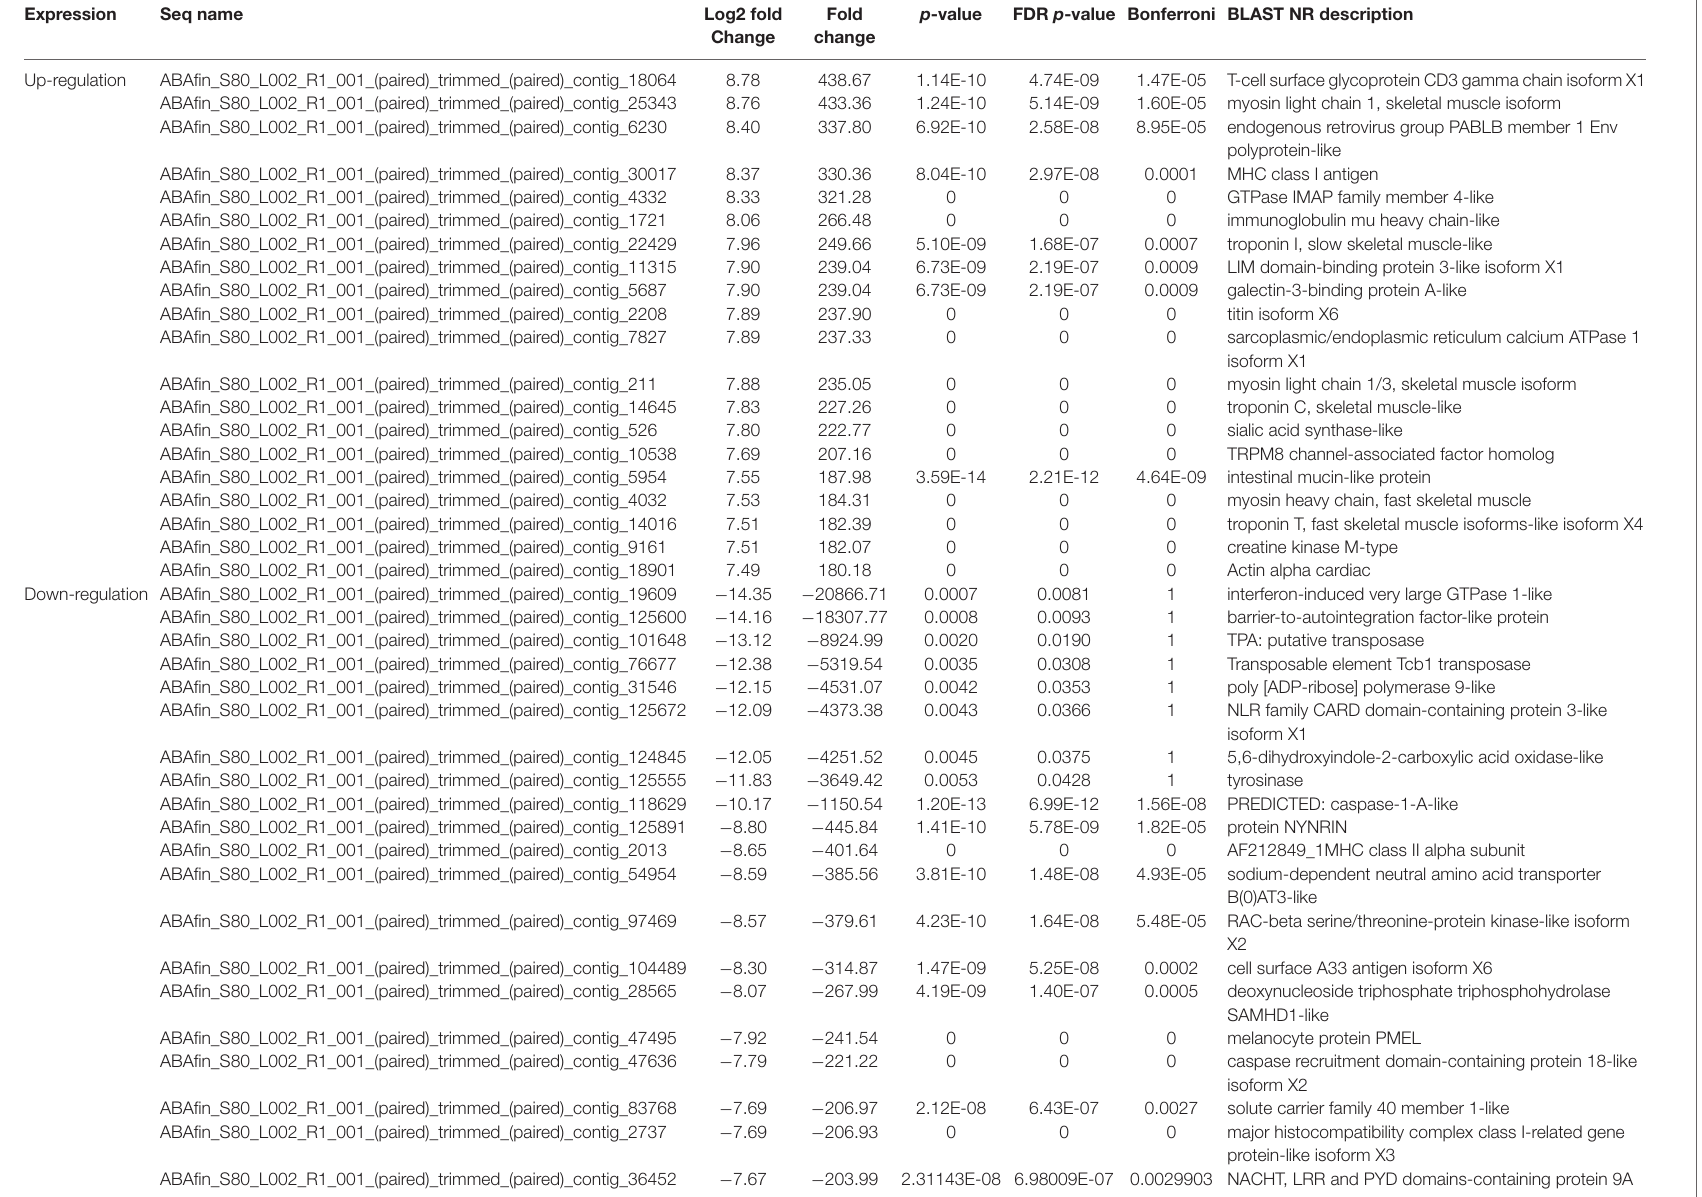
TABLE 3 | List of the first 20 genes showing the highest and lowest differential expression in between A. baenschi albino-type and wild-type.